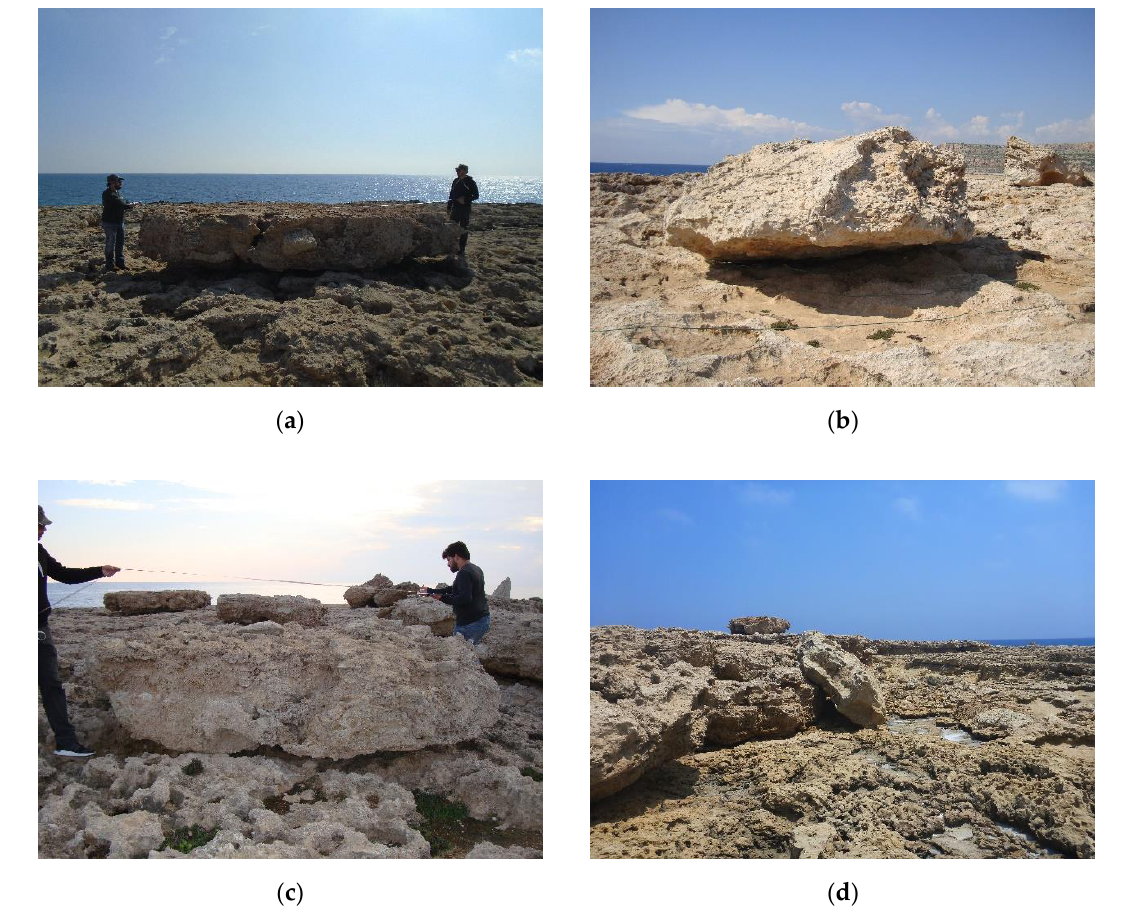
Figure 3. Characteristic boulder deposits from the study area at Cape Greco. ( a , b ) Two of the largest boulders in the study area; the boulder of ( a ) is also visible in the background of ( c ) and ( d ).